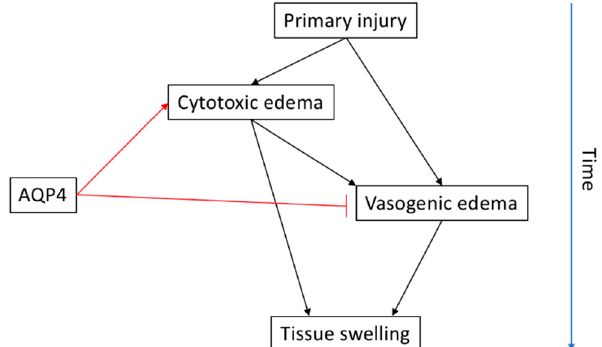
Figure 3. The proposed relationship between AQP4 and cytotoxic and/or vasogenic edema following primary injury over time. AQP4 appears to facilitate cytotoxic edema while aiding the clearance of vasogenic edema at later stages.